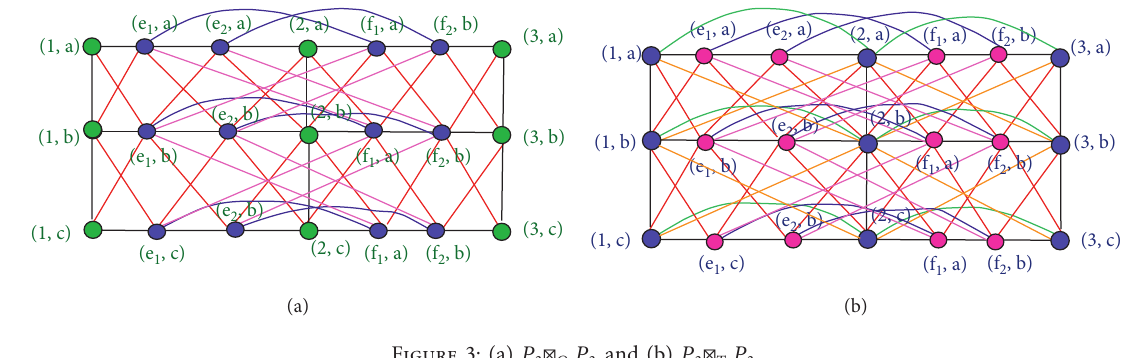
P ⊠ Q and (b) P 3 3 2